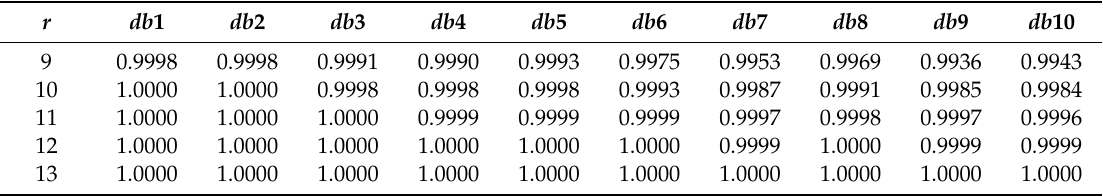
Table 14. Experimental results ( SSIM ) of 3D tomographic 8-bit image “wmri” DWT by using bit-width r of Daubechies wavelets filters coe ffi cients.